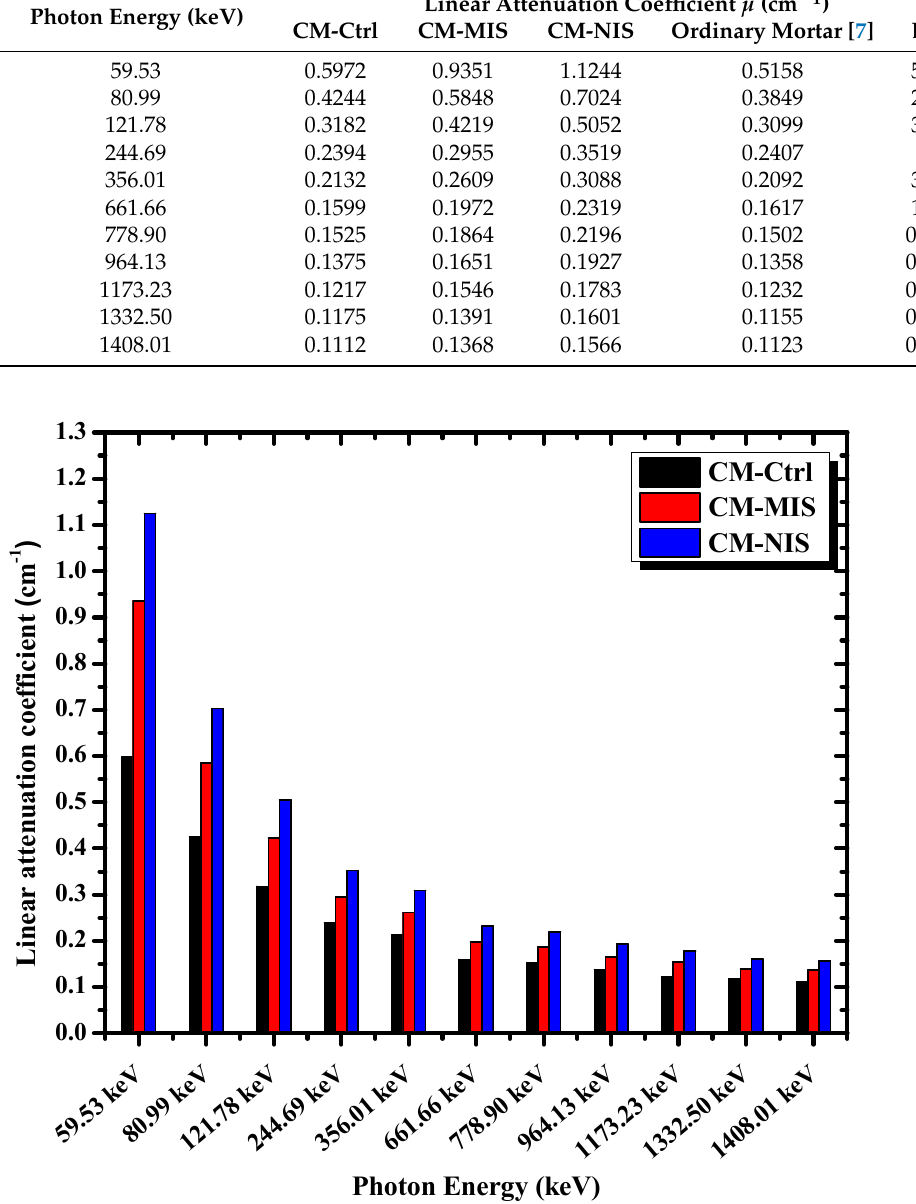
Figure 7. The histogram of the linear attenuation coefficients of the tested mortars as a function of photon energy. Table 4. The values of LACs of the tested mortars in addition to lead.